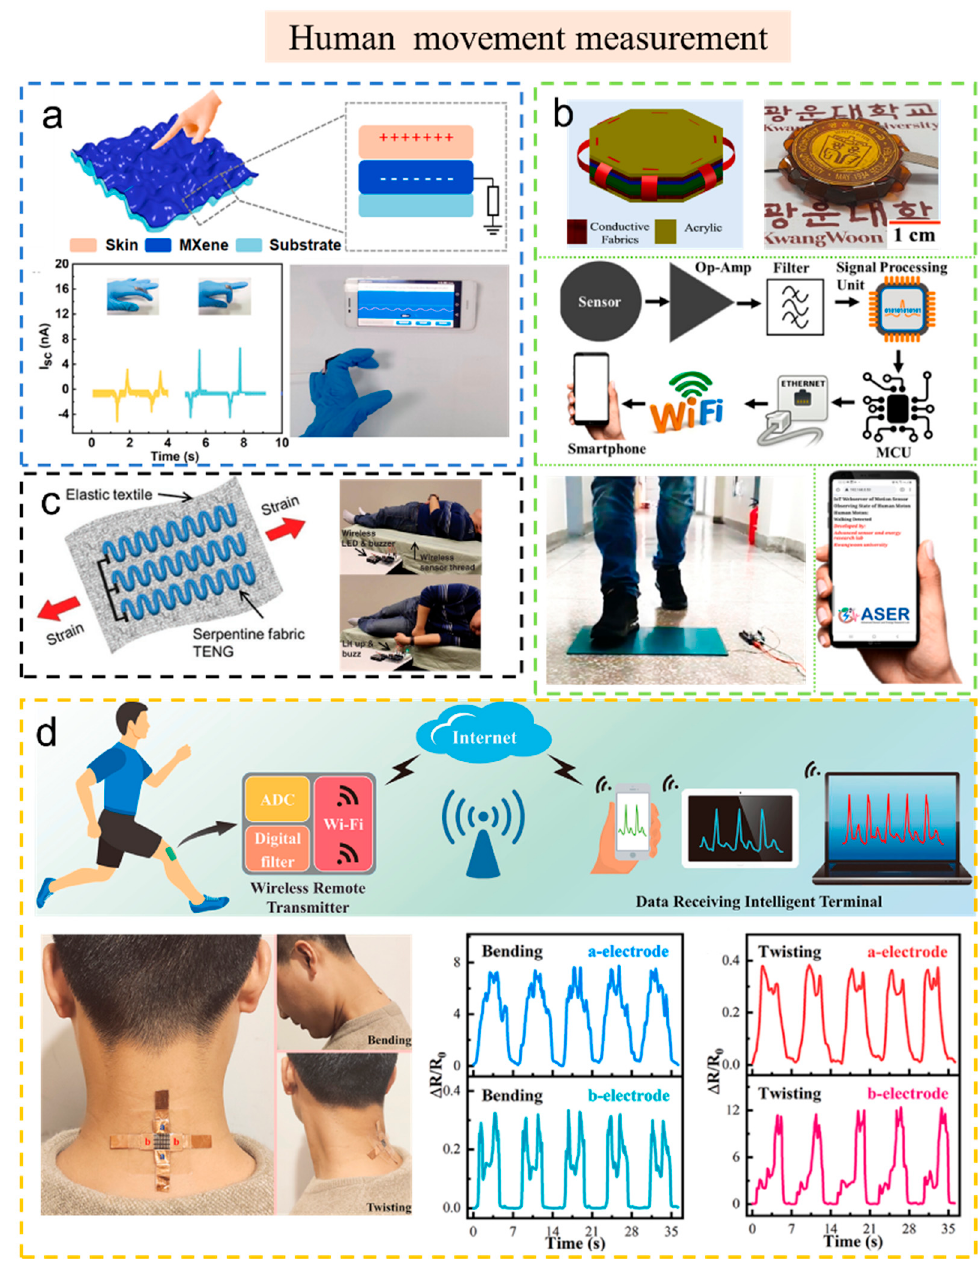
Figure 5. The self-powered wireless sensors and systems based on TENG used in human movement measurement. ( a ) Highly sensitive self-powered pressure and strain sensor based on crumpled MXene film for wireless human motion detection. Reproduced with permission [78]. Copyright 2022, Elsevier Ltd. ( b ) Cation-functionalized nylon composite nanofibrous mat as a highly positive friction layer for robust, high-output triboelectric nanogenerators and self-powered sensors. Reproduced with permission [83]. Copyright 2021, Elsevier Ltd. ( c ) Single-thread-based wearable and highly stretchable TENGs and their applications in cloth-based biomedical sensing. Reproduced with permission [84]. Copyright 2016, John Wiley & Sons. ( d ) Self-powered and multi-mode flexible sensing film with patterned conductive network for wireless monitoring in healthcare. Reproduced with permission [85]. Copyright 2022, Elsevier